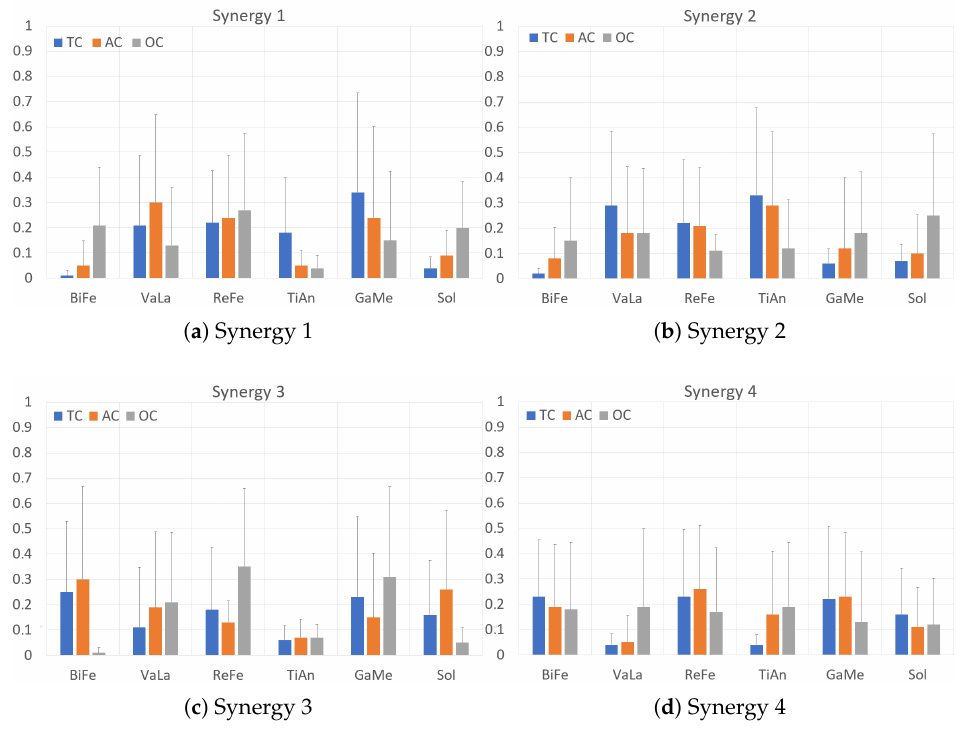
Figure 10. Average muscle synergies (right leg). Table 4. PIs provided by PEPATO testbed. See Section 2.5.3 for the description of each PI. Data are averaged across walking conditions. FWHM and CoA are expressed as % gait cycle. 3 statistical difference between AC and OC